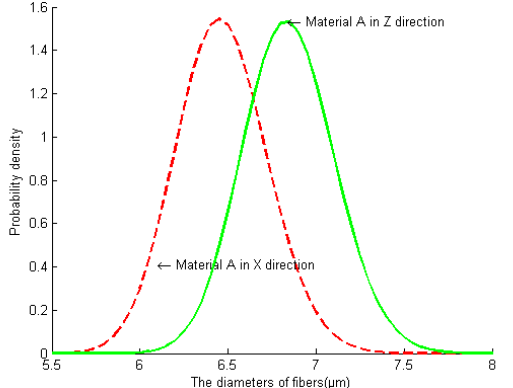
Figure 6. Fiber diameter distribution of axially braided C / C composites in di ff erent directions (more Figure 6 . Fiber diameter distribution of axially braided C/C composites in different directions ( more than 1000 fibers). than 1000 fibers ). Table 3. Volume content of fiber reinforced phase in axially braided C/C composites (The data obtained from the observation of 100 samples).